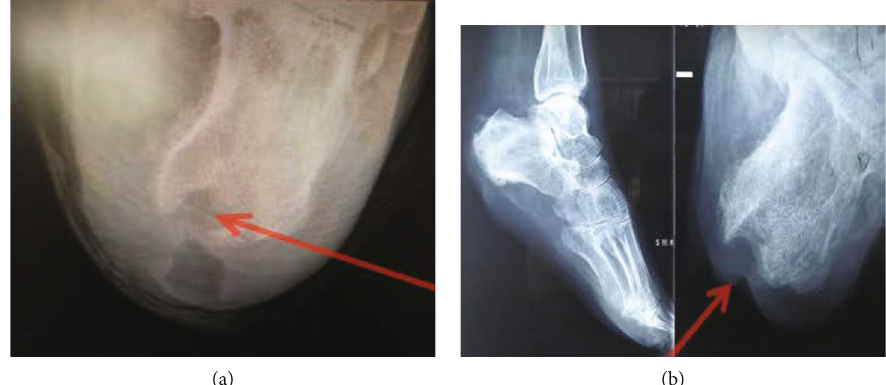
Figure 3: Clinical radiographies of diabetic heel ulceration (a) before surgery and (b) 12 weeks after surgery. The arrow head is pointed on the calcaneus.